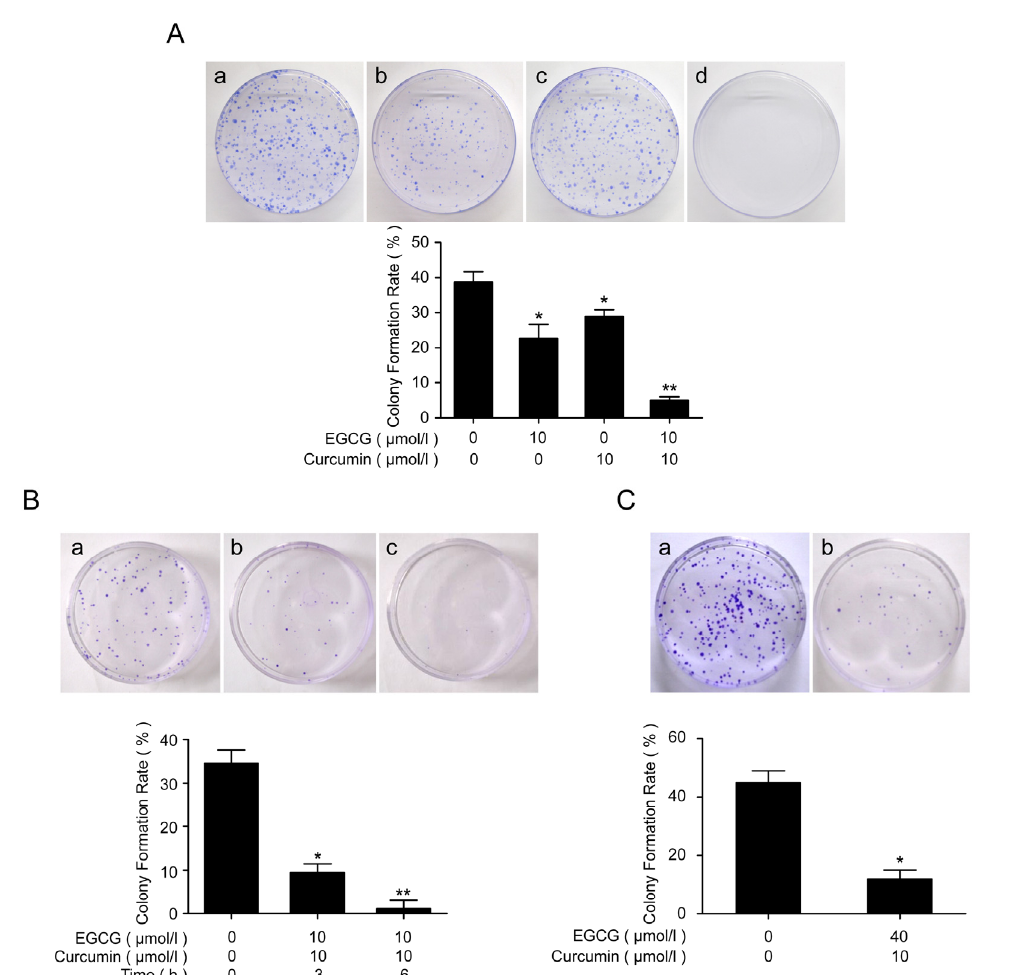
Figure 5. EGCG in combination with curcumin repressed clonal formation of NSCLC cells. ( A ) EGCG in combination with curcumin repressed clonal formation of A549 cells. About 1 × 10 3 A549 cells were seeded onto the 100 mm plates after the indicated treatment and changed for fresh medium every 3 days. ( a ) control; ( b ) treated with 10 μ mol/L of EGCG for 24 h; ( c ) treated with 10 μ mol/L of curcumin for 24 h; ( d ) treated with 10 μ mol/L of EGCG and 10 μ mol/L of curcumin for 24 h; ( B ) EGCG in combination with curcumin repressed clonal formation of A549 cells in a time-dependent manner. About 5 × 10 2 A549 cells were seeded onto the 60 mm plates after the indicated treatment and changed for fresh medium every 3 days. ( a ) control; ( b ) treated with 10 μ mol/L of EGCG and 10 μ mol/L of curcumin for 3 h; ( c ) treated with 10 μ mol/L of EGCG and 10 μ mol/L of curcumin for 6 h; ( C ) EGCG in combination with curcumin repressed clonal formation of NCI-H460 cells. About 1 × 10 3 NCI-H460 cells were seeded onto the 100 mm plates after the indicated treatment and changed for fresh medium every 3 days; ( a ) control; ( b ) treated with 10 μ mol/L of EGCG and 10 μ mol/L of curcumin for 24 h. After 7 or 10 days, visible colonies were fixed and stained with crystal violet staining solution. The colony formation rate was calculated (* p < 0.05, ** p <